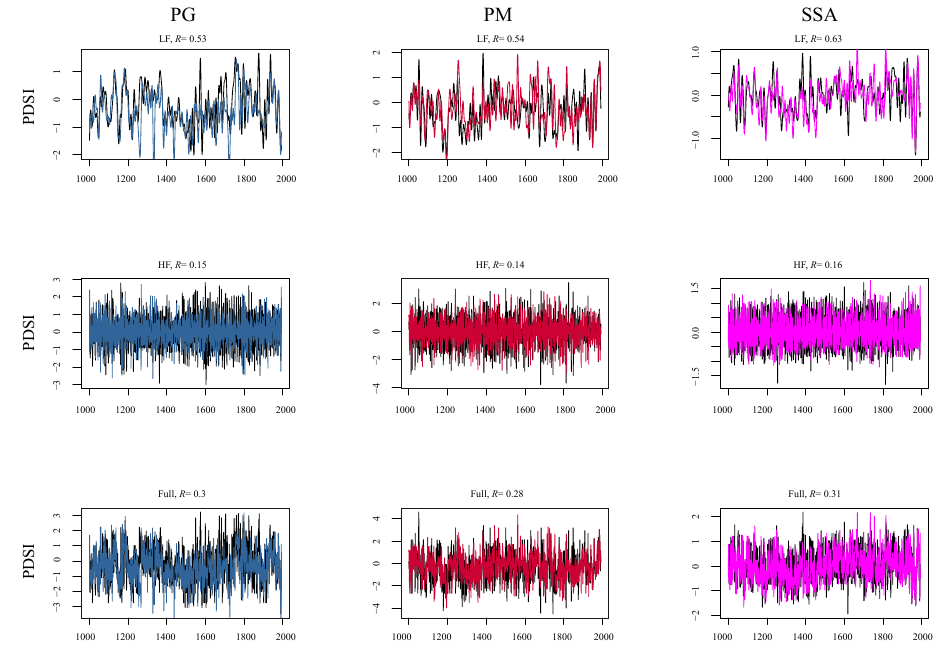
Figure 9. Comparison between the reconstructions made from the full proxy dataset (colored lines, same colors as in Figure 3) and the reconstructions performed from only the proxies that go back to AD 1000 (black lines). The top and middle rows present the LF and HF components, respectively, while the lower row depicts the comparison over the full spectra. Correlation coefficients ( R , N=994) are shown in the title, for each frequency band and for each region. Not shown here: ANDES ( R = 0.28, for the full spectra) and ST ( R = 0.57, for the full spectra).